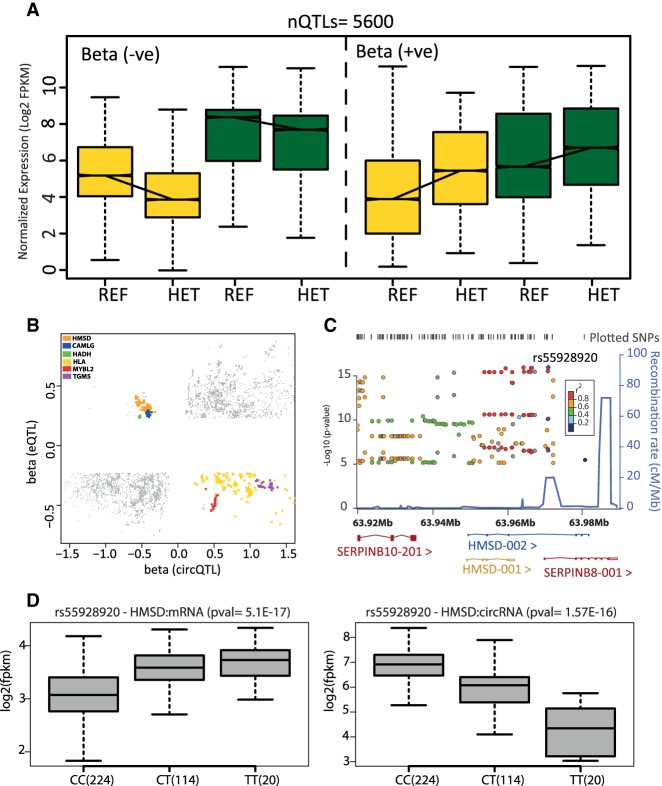
Effects of shared QTL variants on gene expression. (A) Boxplots representing distribution of average circRNA and mRNA expression from all individuals with a given genotype for shared QTLs. (B) Spearman rank correlation defines the effect size (β) and indicates the direction of change from reference to alternate allele. Each point in the plot is a shared QTL marker with the x-axis representing β for circRNA association and the y-axis representing β for mRNA association. The high density of points in the upper right and bottom left quadrants show that most shared QTLs have similar effects from their reference and alternate alleles on circular and linear expression. Colored points represent QTLs that have opposite effects on circular and linear expression of their host genes. (C) Region association plot for HMSD circRNA. The shared intronic QTL (rs55928920) is associated with HMSD circRNA (P = 1.57 × 10−16) as well as mRNA expression (P = 5.1 × 10−17). Values of r2 are based on the CEU HapMap 2 samples. CEU HapMap 2 recombination rates are indicated in blue on the right y-axes as obtained using LocusZoom (http://csg.sph.umich.edu/locuszoom). (D) Reference allele of rs55928920 is associated with higher expression of circRNA from the second and fourth exons of the HMSD transcript (HMSD-002) and lower expression of the mRNA transcripts from HMSD and SERPINB8 genes.